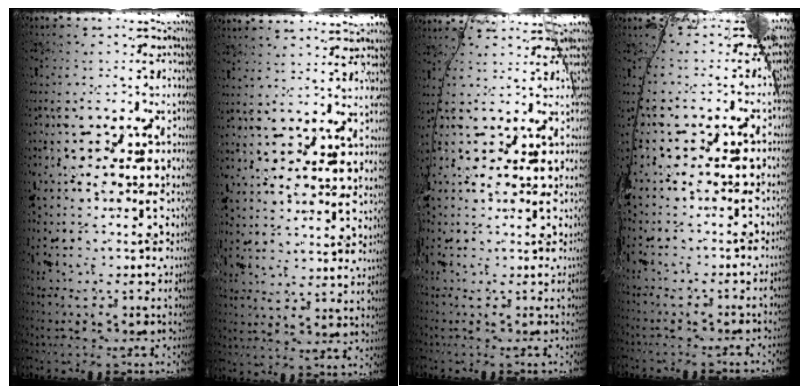
Figure 13. Image of the failure process of specimen D6.